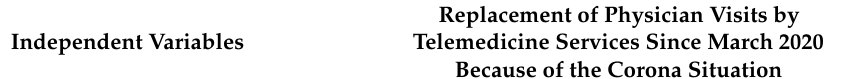
Table 2. Correlates of replacement of physician visits by telemedicine services since March 2020 because of the corona situation (0 = no, not replaced; 1 = yes, once; yes, several times; yes, always). Findings of multiple logistic